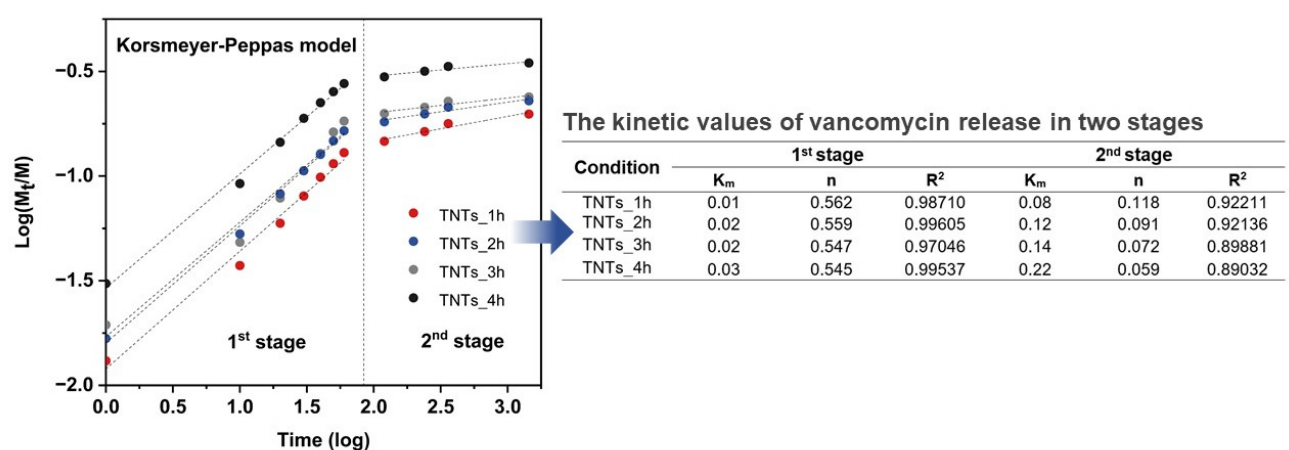
Figure 9. The measured values of vancomycin release was fitted to Korsmeyer-Peppas model which describes the behavior in two main stages. The tabulated fitting the kinetic values of K and n from Korsmeyer-Peppas model, which described the kinetics of drug release in two stages. The 1st stage is the anomalous diffusion or Non-Fickian diffusion in the burst stage in which the n values are in the range of 0.54–0.56 while the 2nd stage shows the n values in the range of 0.05–0.12 suggesting Quasi-Fickian diffusion behavior.